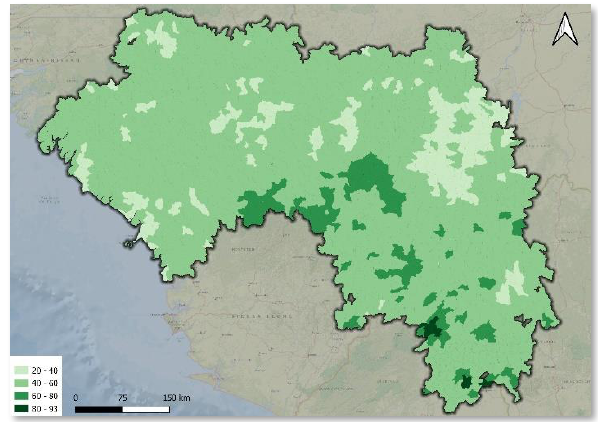
Figure 4. Map of Green background landscape Indicator (GBLI) per SELU in